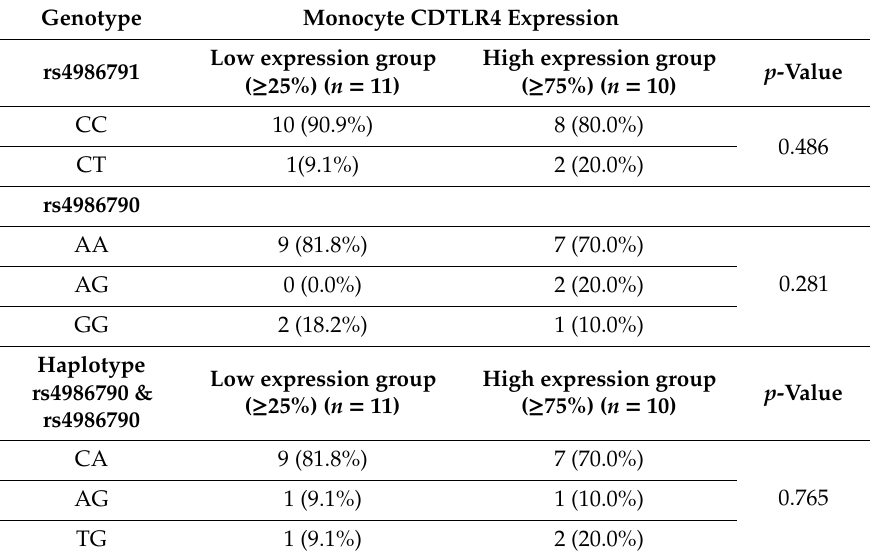
Table 5. Genotype and haplotype distribution of rs4986791 and rs4986790 among subjects with low